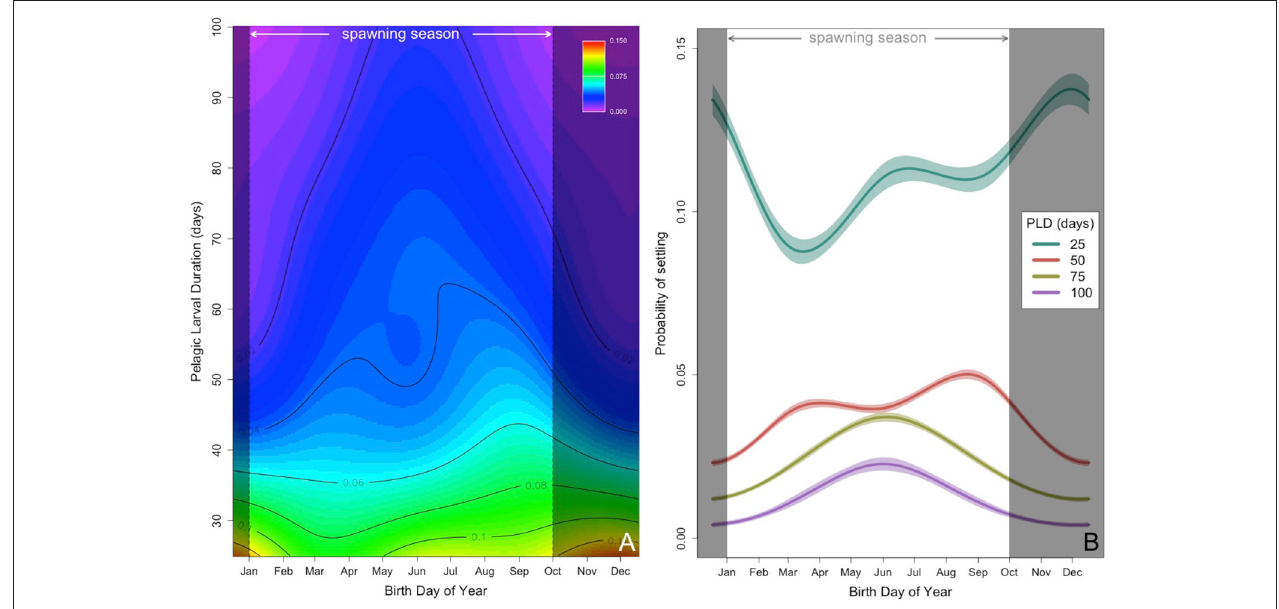
FIGURE 3 | (A) Predicted probability of settling (contours and color scale), from high (red) to low (purple) probability, as a function of birth date (x-axis, BirthDay ) and PLD (y-axis, days). (B) Predicted probability of settling ( ± 2 standard error) as a function of birth day of year ( BirthDay ) and PLD (days, colors, with green = 25 days, red = 50 days, yellow = 75 days, and purple = 100 days). In both panels, times outside the common spawning season are shaded in gray ( Walsh, 1987; see section Discussion). Other predictors are held constant at Location = Punalu’u, Spine = present, Moon =